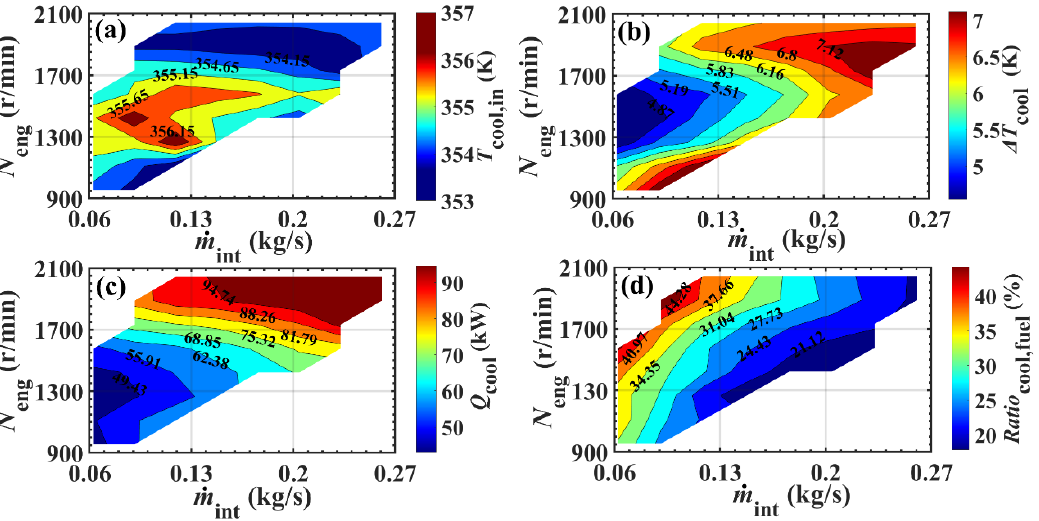
Figure 3. Waste heat characteristics of coolant in variable working environments. ( a ) Inlet temperature of coolant. ( b ) Temperature different of coolant. ( c ) Heat transfer rate of coolant. ( d ) Proportion of heat transfer rate in coolant.